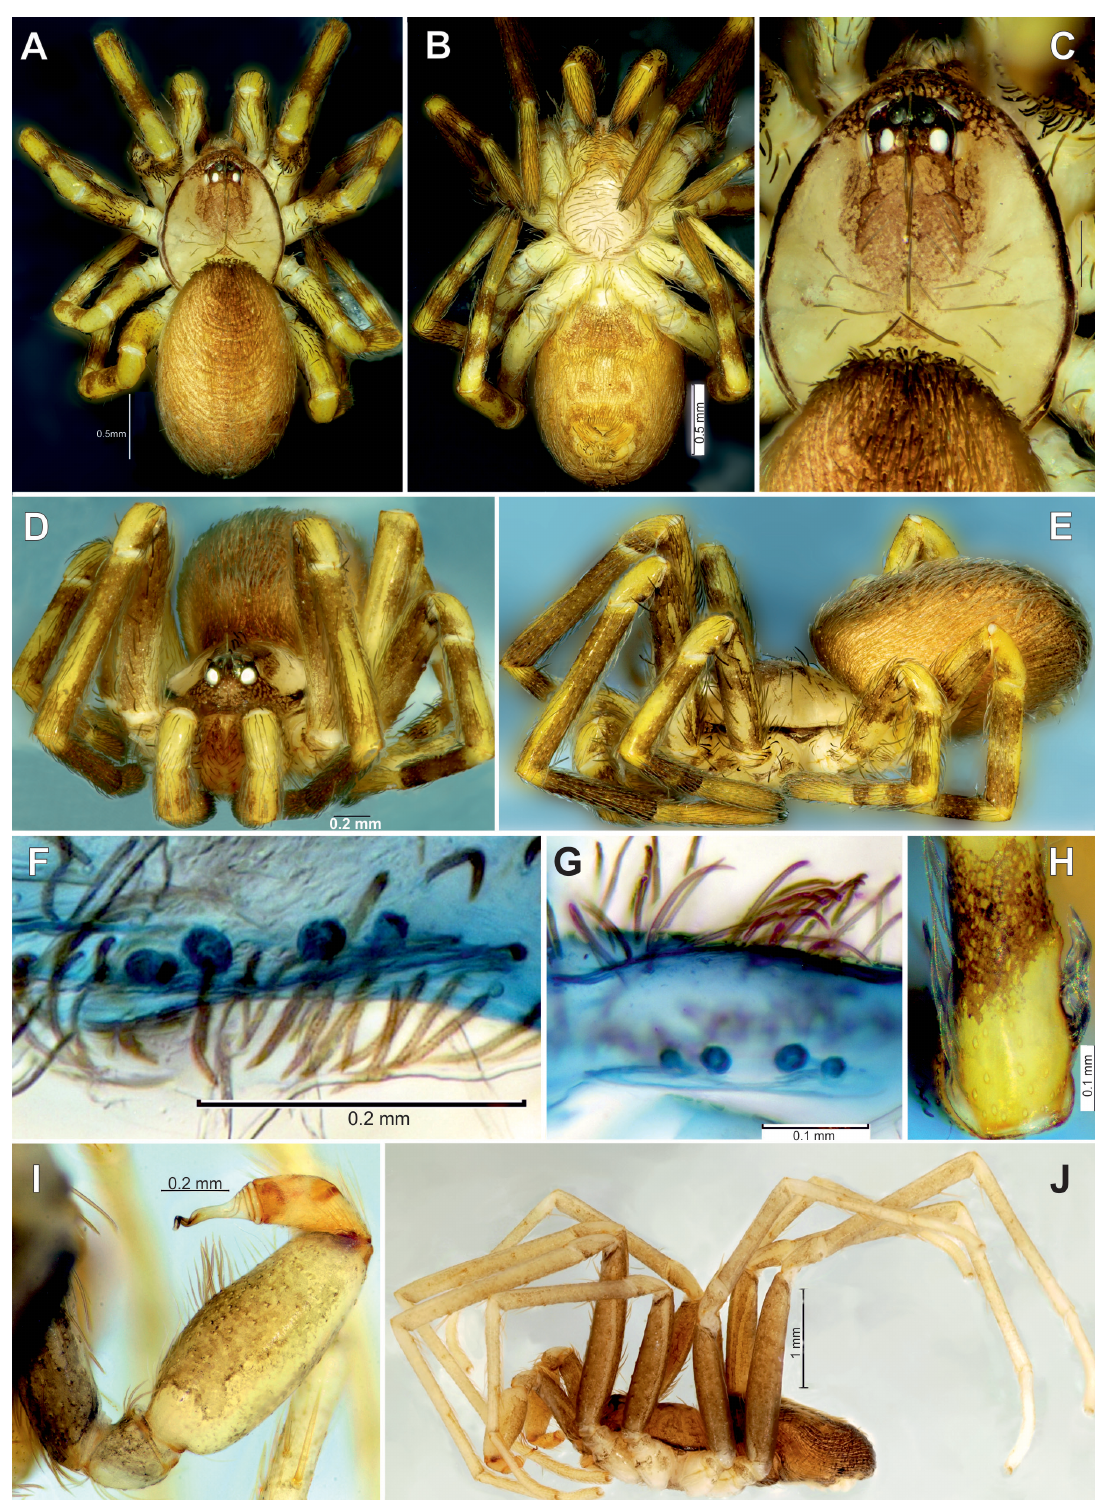
Fig. 10. Somatic characters and copulatory organs of Zaitunia kunti sp. nov., paratype, ♀ from Turkey ( A – H ) and holotype, ♂ ( I–J ). — A–B . Habitus, dorsal and ventral. C . Prosoma, dorsal. D – E . Habitus, frontal and lateral. F – G . endogyne, dorsal. H . Calamistrum, dorsal. I . Palp, retrolateral. J . Habitus, lateral. Scale bars: a–B = 0.5 mm; D–F, i = 0.2 mm; G–H = 0.1 mm; J = 1.0